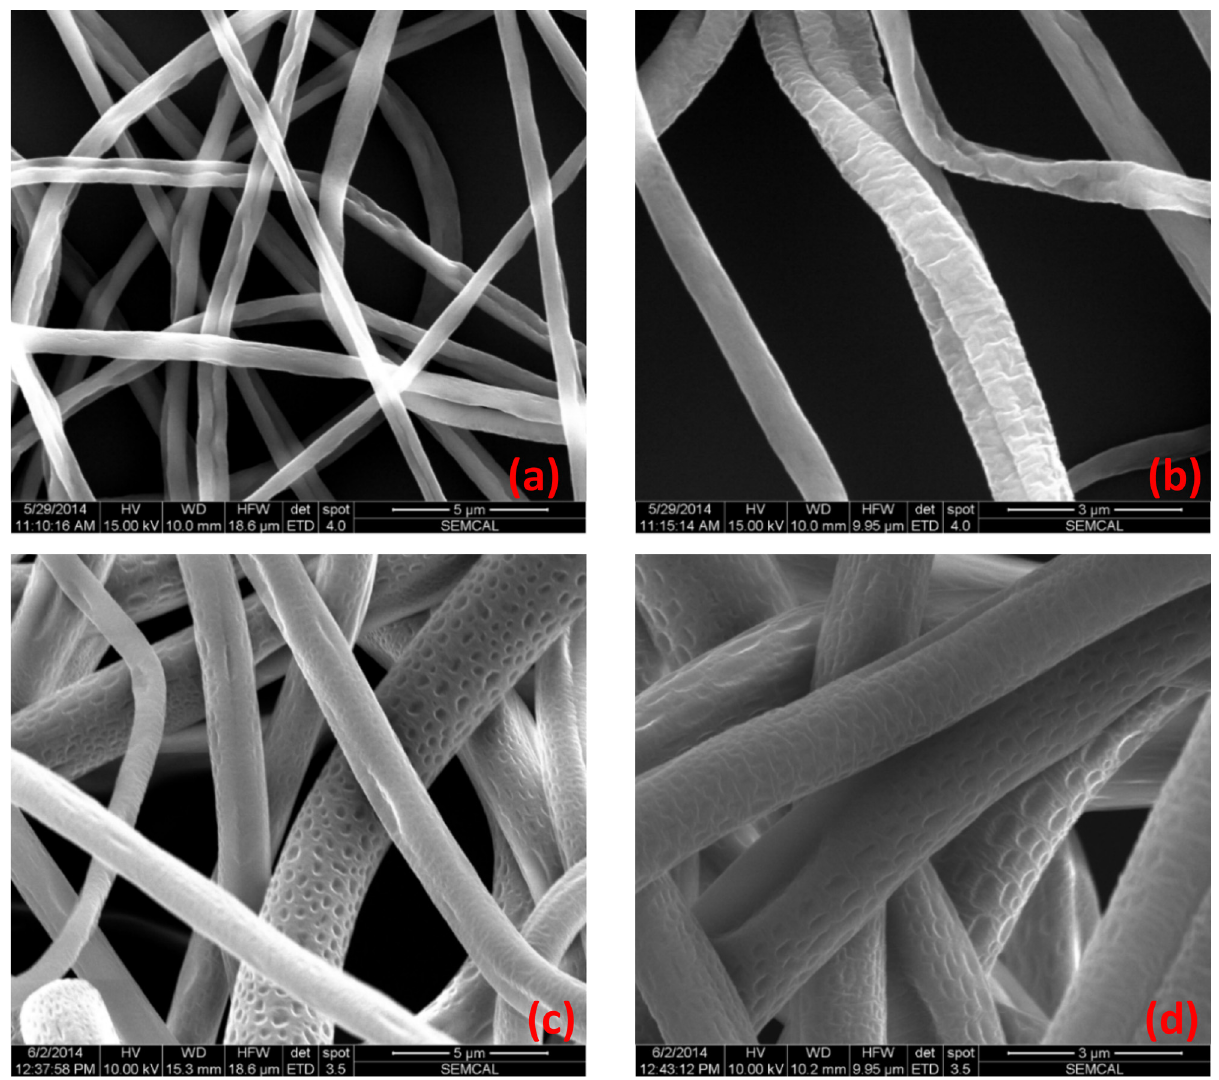
Figure 2: SEM images showing electrospun THV nano fi bers prepared from the THV/acetone solution with the concentration of 15 wt%; 15 cm_22 gauge_19 kV, sample 1 as listed in Tables 1 and 2 ( a and b ) and 15 cm_22 gauge_16 kV, sample 2 as listed in Tables 1 and 2 ( c and d )